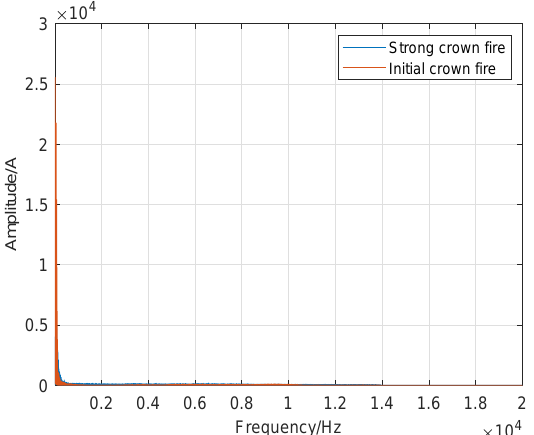
Figure 22. Comparison of strong crown fire and initial crown